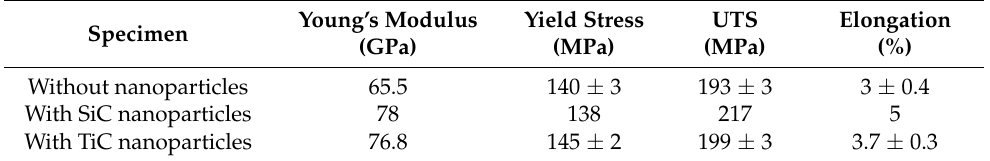
Table 4. Average tensile properties of joints without and with addition of TiC and with SiC nanoparticles. Young’s Modulus Yield Stress UTS Elongation Specimen (GPa) (MPa) (MPa) (%) Without nanoparticles 65.5 140 ± 3 193 ± 3 3 ± 0.4 With SiC nanoparticles 78 138 217 5 With TiC nanoparticles 76.8 145 ± 2 199 ± 3 3.7 ±